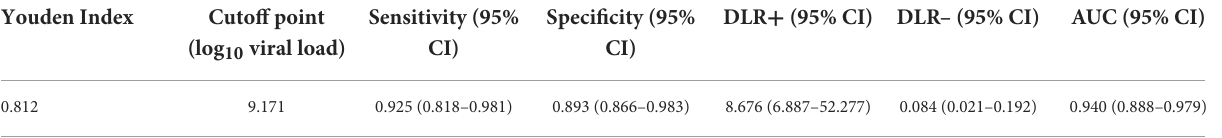
TABLE 2 Results of the receiver operating characteristic analysis for RVA RT-qPCR using antigen-capture ELISA as a reference test for RVA detection in feces of 175 diarrheic calves that tested negative ( n = 122, controls) or positive ( n = 53, cases) by ELISA. Youden Index